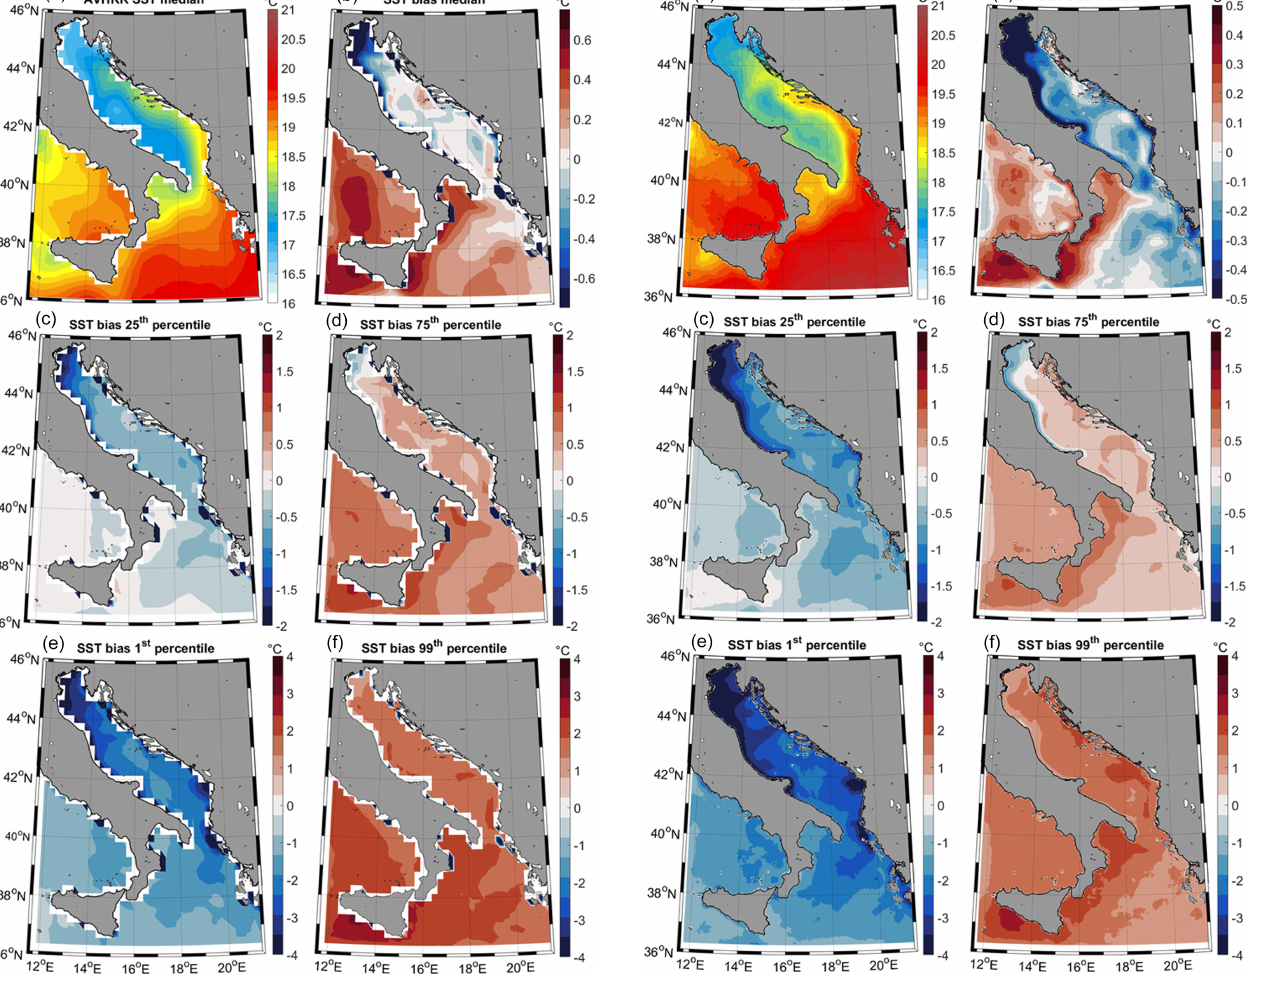
Figure 4. Median of the AVHRR daily sea surface temperature product (a) as well as the median (b) and 25th (c) , 75th (d) , 1st (e) , and 99th (f) percentiles of the daily sea surface temperature biases between AdriSC ROMS 3km model results and the AVHRR prod- uct during the 1987–2017 period.